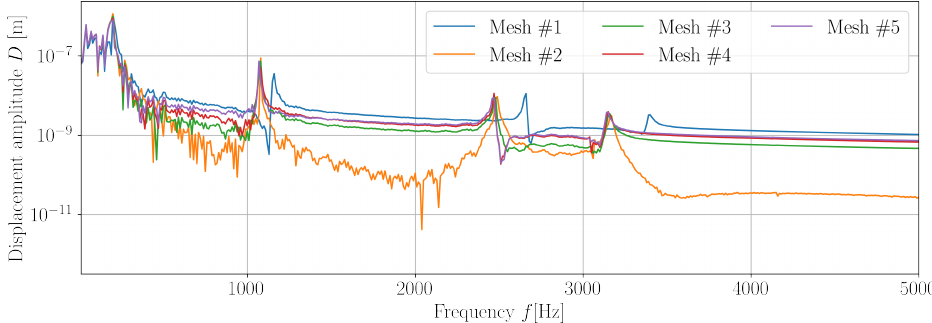
Figure 7. Spectrum of displacement along the y axis at probe S3 for finite element mesh indepen- dence